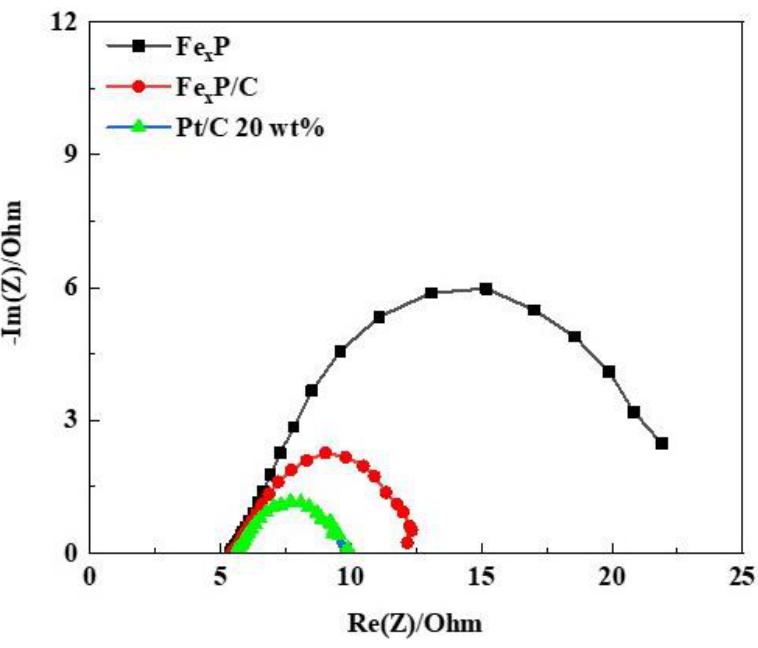
Figure 4. Nyquist plot for 20 wt% Pt/C, FexP, and FexP/C in 1 M KOH .